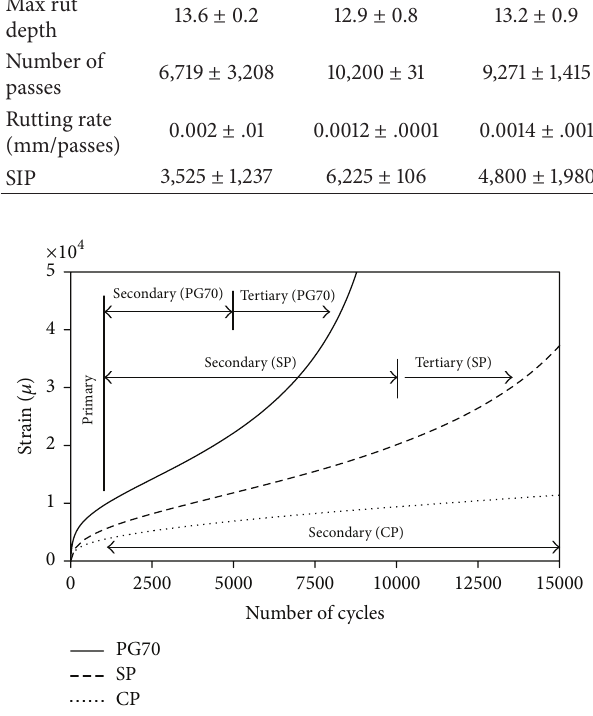
Figure 6: Uniaxial strain measurements of FN